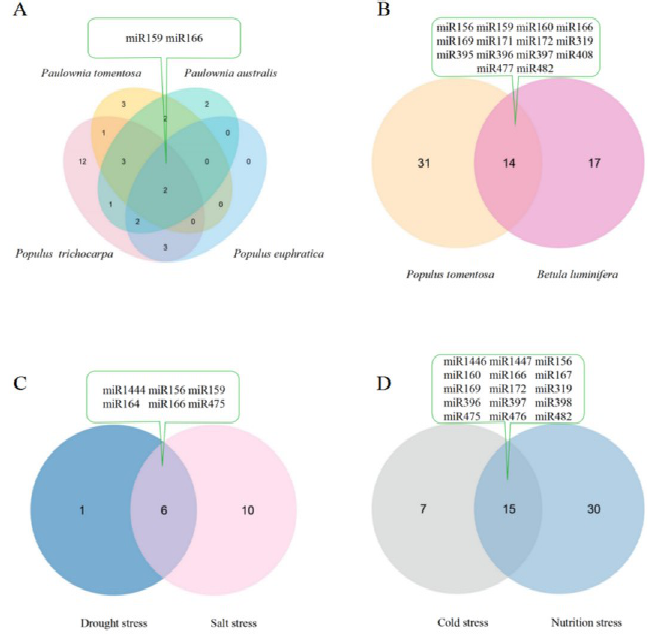
Figure 1. Intersection of abiotic stress responsive miRNAs verified by degradome sequencing in different forest tree species based on previous studies [17,19,21,23,31,39,48,49,58,59]. ( A ) Drought stress-responsive miRNAs in Populus trichocarpa , Paulownia tomentosa , Paulownia australis , and Pop- ulus euphratica ; ( B ) Nutrition stress-responsive miRNAs in Populus tomentosa and Betula luminifera ; ( C ) Drought and salt stress-responsive miRNAs in Populus euphratica ; ( D ) Cold and nutrition stress- responsive miRNAs in Populus tomentosa . Note: the miRNAs in the green text box are the common content of